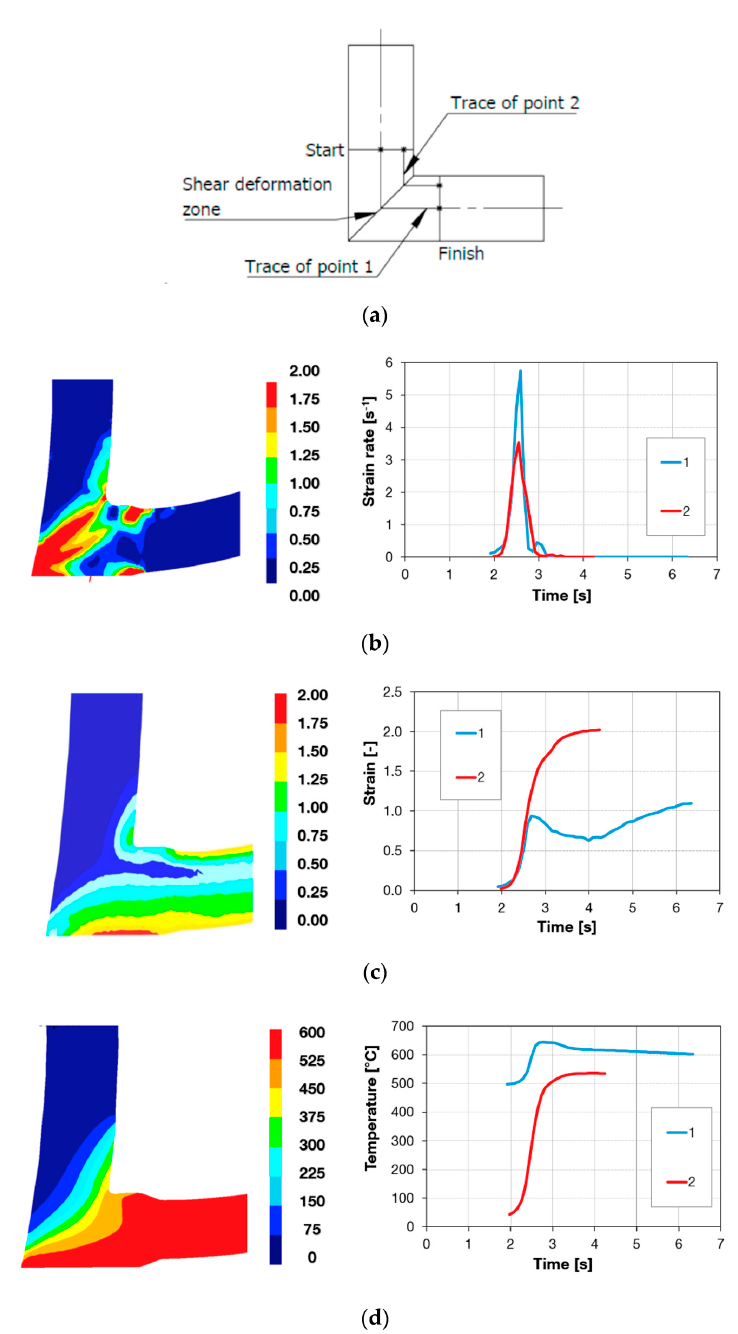
Figure 2. Result of FEM simulation: ( a ) Paths of the points under examination; ( b ) Strain rate distribution [s − 1 ] and time trace of strain rate for points 1 and 2; ( c ) true strain distribution [-] and time relation of true strain for points 1 and 2; ( d ) temperature distribution over time for tracking points dependences of temperature for points 1 and